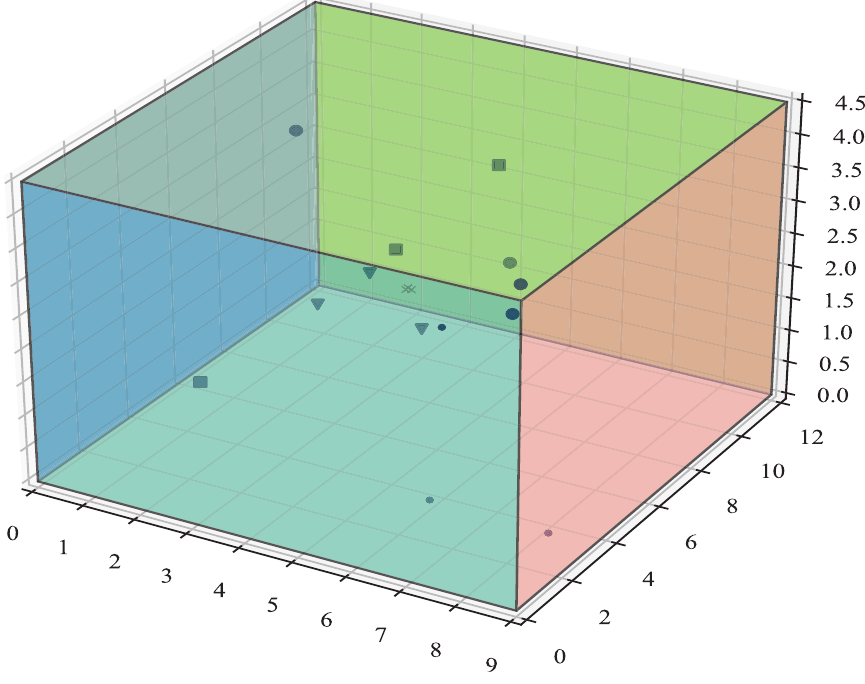
Figure 10. Simulation of a 3D matrix